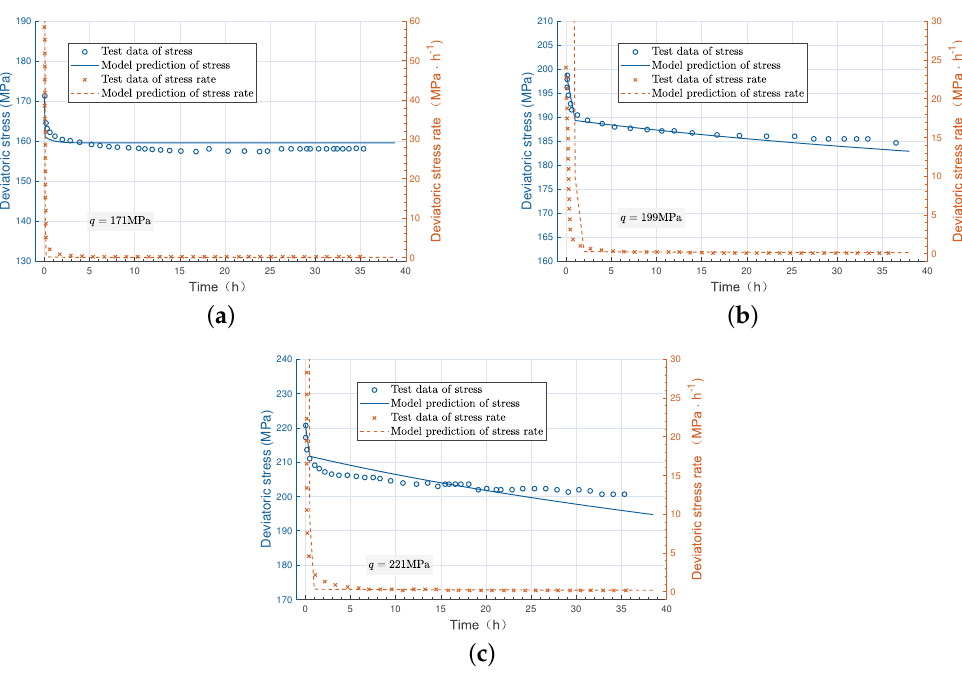
Figure 9. Analytical prediction of relaxation tests on Beishan granite with different initial deviatoric stress under confining pressure p c = 15 MPa. ( a ) q = 171 MPa; ( b ) q = 199 MPa; ( c ) q = 221